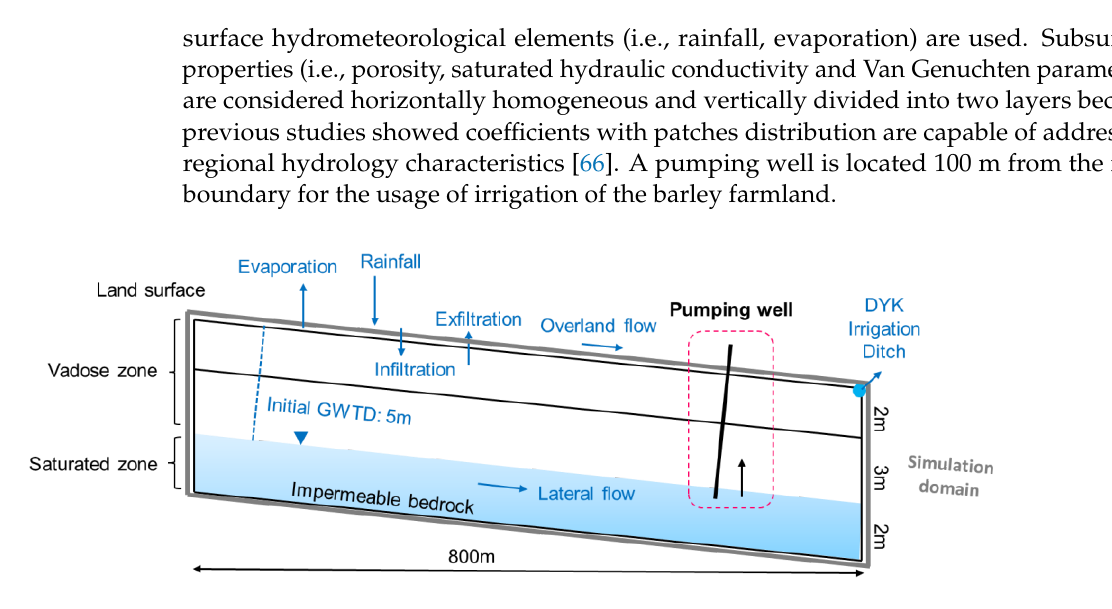
Figure 8. Illustration of simulation configurations of the DYK case: 2D view and basic components of the section of the DYK case.